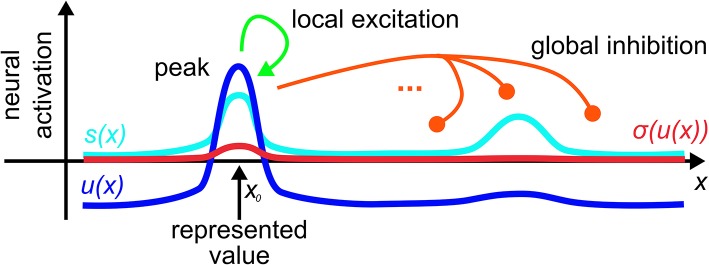
A dynamic neural field spanning a metric dimension, x, represents a specific value, x0, along that dimension through a supra-threshold activation peak that is stabilized by local excitatory and global inhibitory interactions.